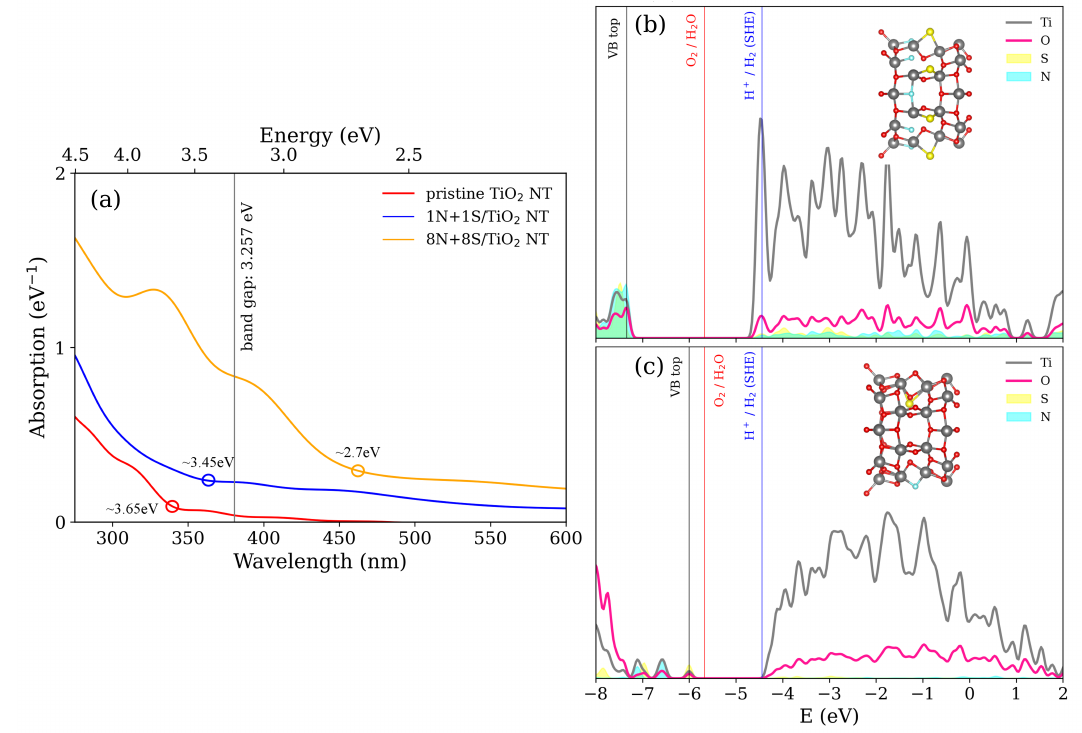
Figure 5. Absorption spectra and calculated projected density of states (PDOS) of N+S-codoped TiO 2 NT. ( a ) absorption spectra include pristine TiO 2 NT, 8N+8S/TiO 2 doped NT, and 1N+1S/TiO 2 doped NT. ( b ) PDOS for the 8N+8S/TiO 2 NT and ( c ) for the 1N+1S/TiO 2 NT. The insets show the equilibrium atomic structures for each model in